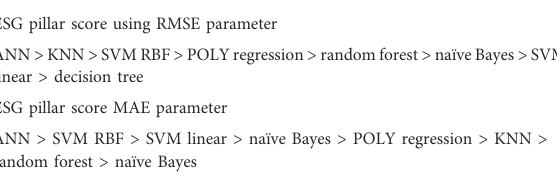
TABLE 12 Comparison of the order of all the techniques used for predicting ESG pillar score. ESG pillar score using RMSE